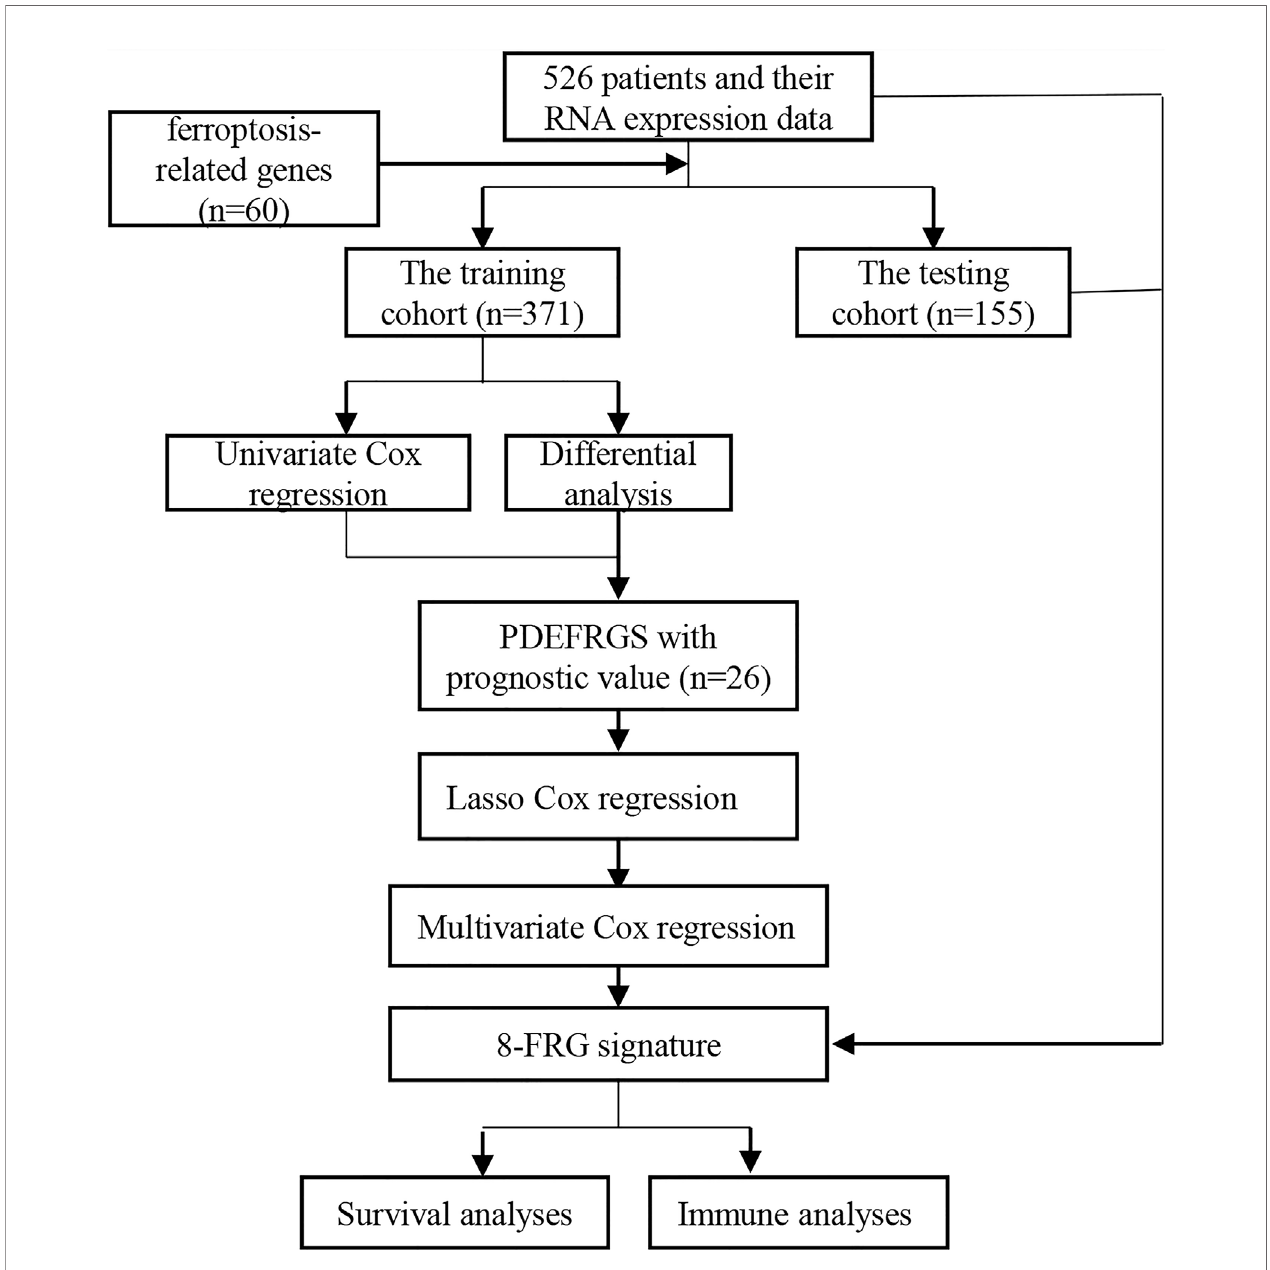
FIGURE 1 | The overall work fl ow of this